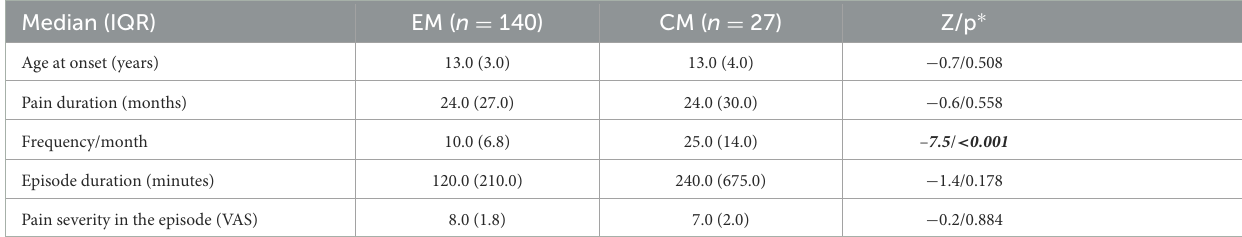
TABLE 3 Pain features in adolescents with migraine according to type.